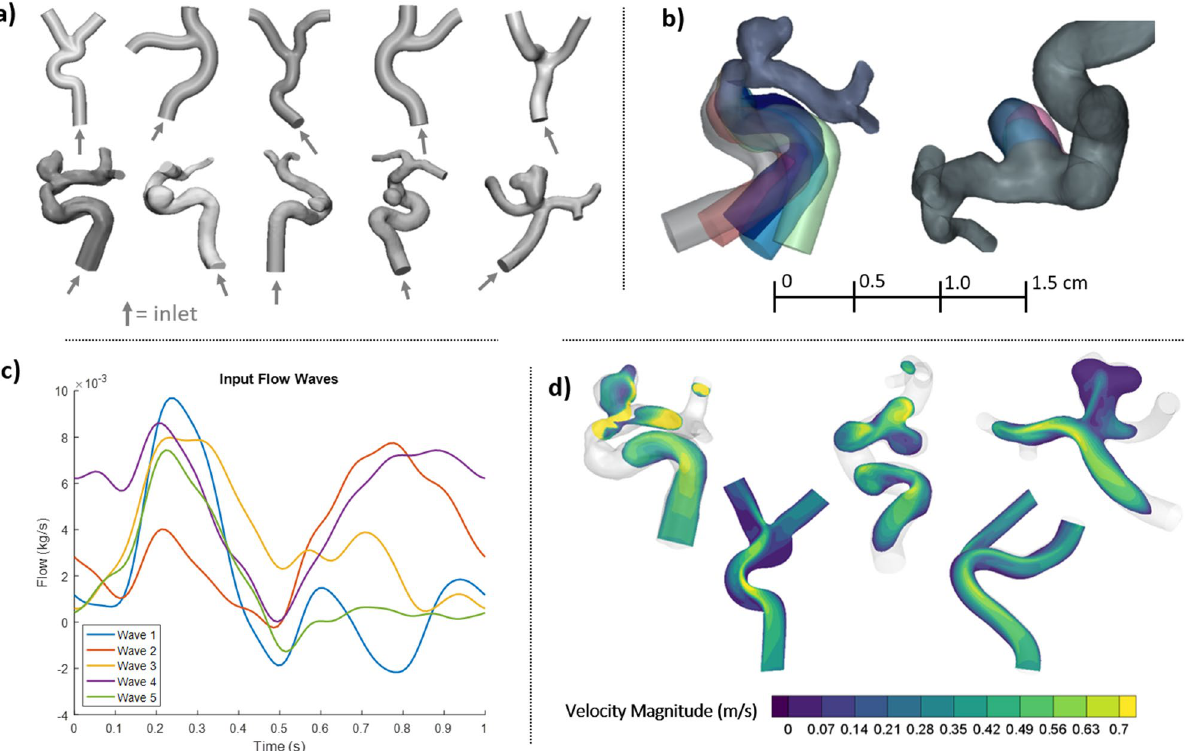
Figure 2. Computational fluid dynamics (CFD) simulations were performed on ( a ) 5 idealized blood vessel models, 5 patient-specific blood vessel models, and ( b ) 20 additional models that were manually modified from patient-derived models. ( c ) Six sets of unique inflow conditions were used with each geometry to create 180 total CFD simulations. ( d ) Example CFD results from representative